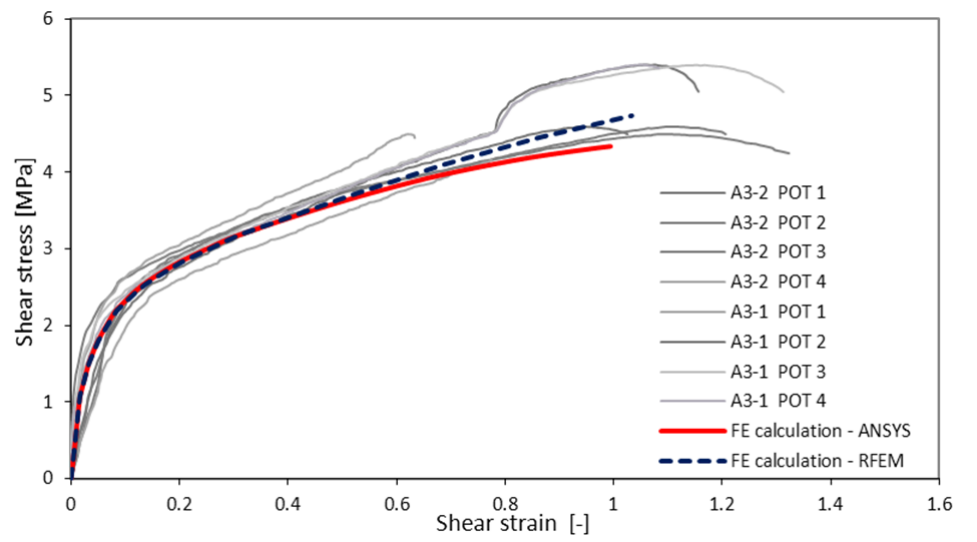
Fig. 8 Comparison of Ansys and RFEM calculations with experiments for